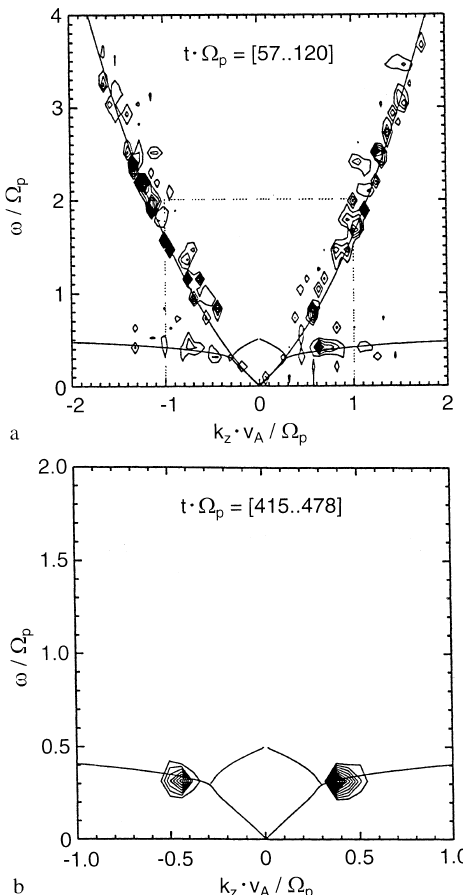
Fig. 5. a (cid:120) (cid:255) k z diagram at an early simulation time; the solid lines correspond to dispersion from linear dispersion theory; b (cid:120) (cid:255) k z diagram at an advanced simulation time; only the unstable mode with maximum growth